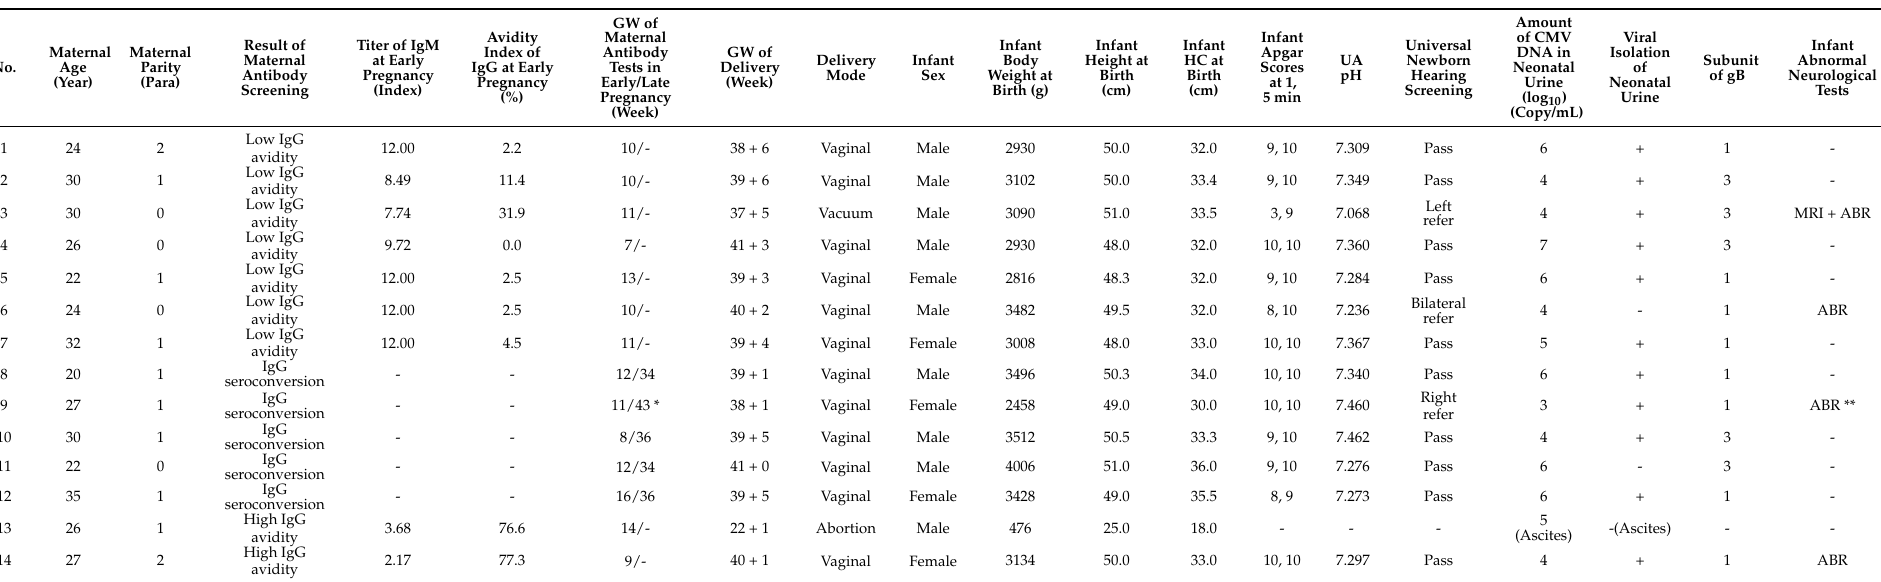
Table 1. Presentation of the 12 and the other 2 congenital cytomegalovirus (CMV) infection cases from mothers with primary (the revised cutoff period) and non-primary (the original cutoff period) CMV infection,